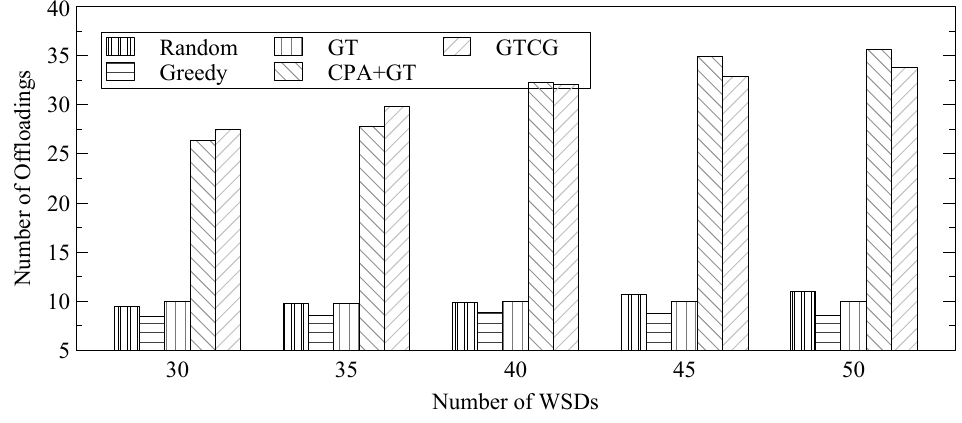
Figure 3. Average Number of Offloadings for Different Number of